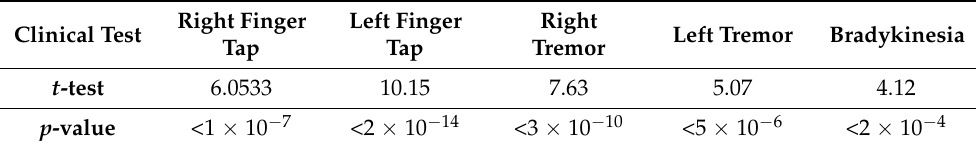
Table 6. t-Statistics values between the correlation of latent and non-latent space values with each clinical data sample for the 30 runs.